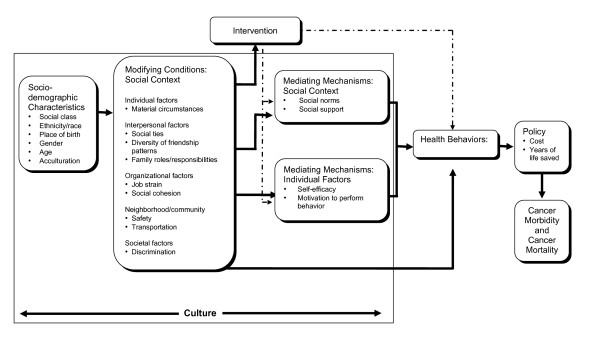
Social contextual model.